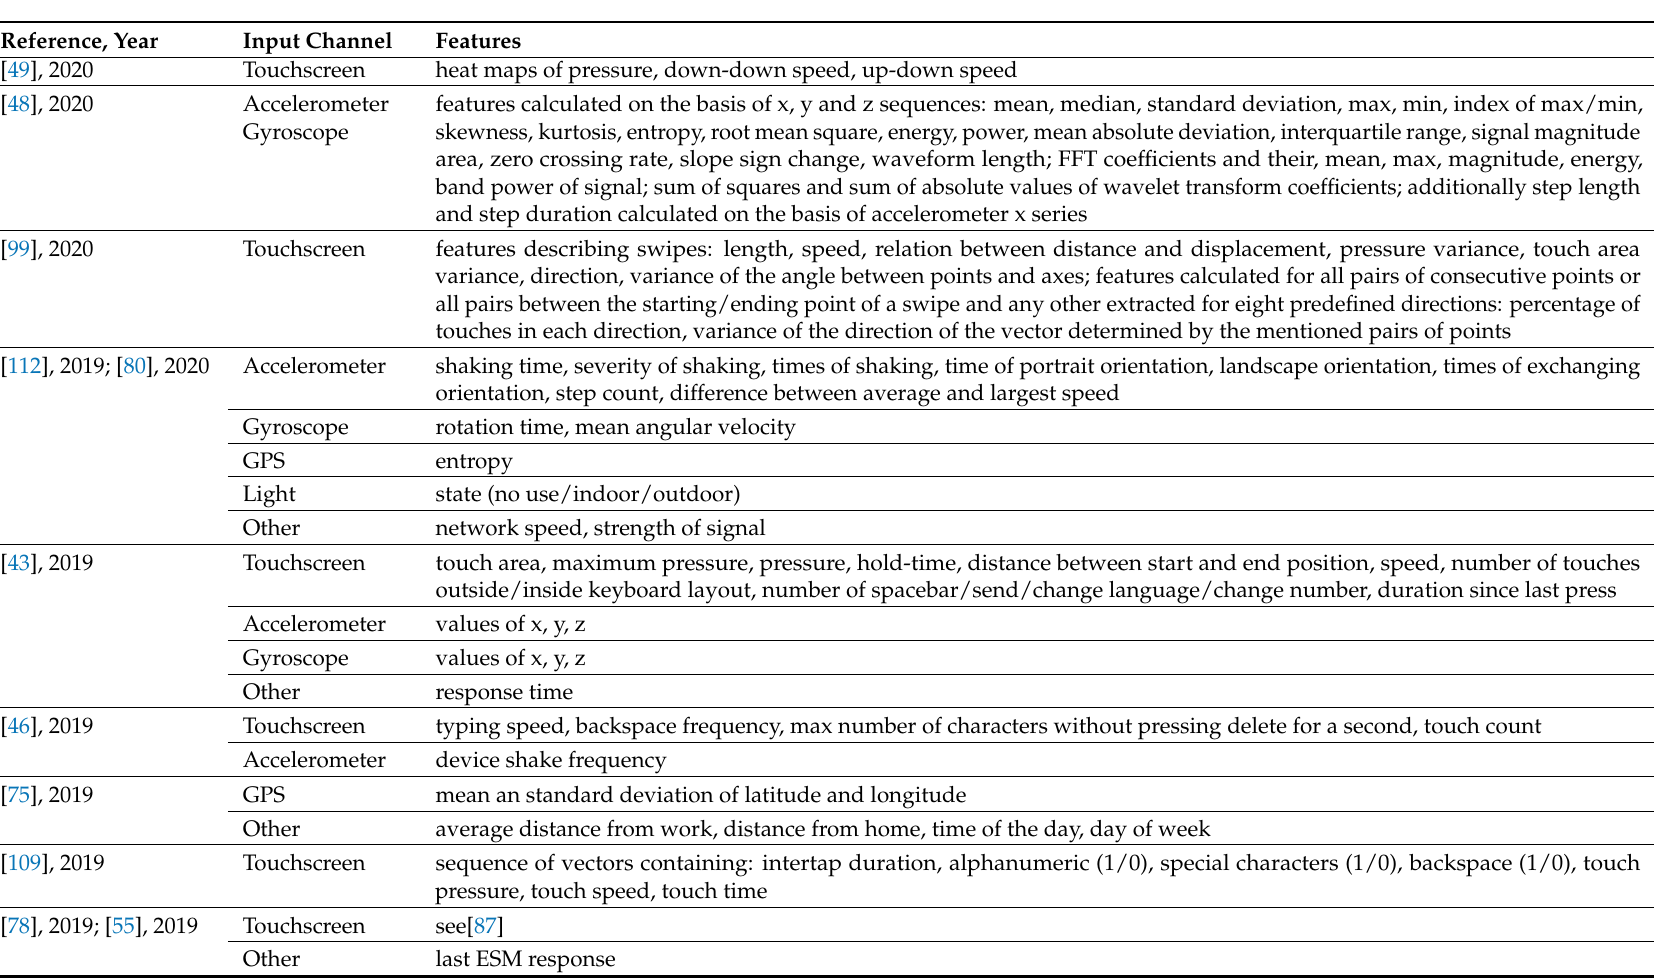
Table 3. Features extracted in the reviewed